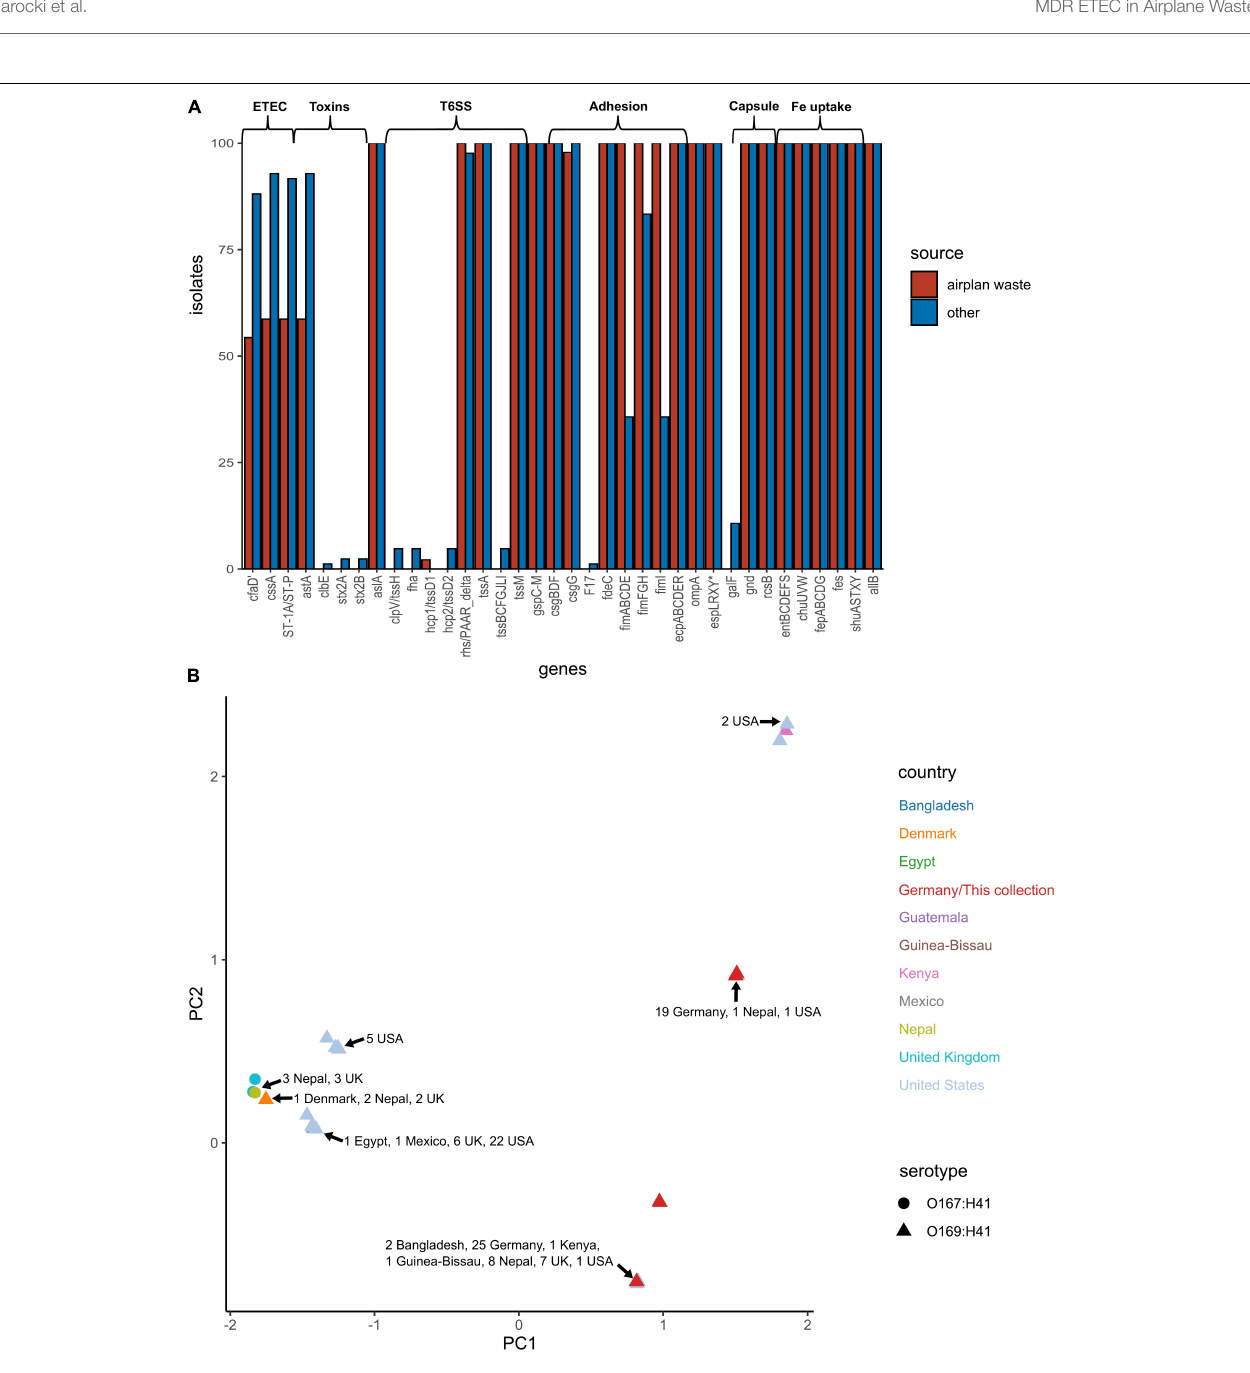
FIGURE 5 | Virulence-associated gene (VAG) profile of E. coli ST182 strains. (A) Bar graph comparing distribution of VAGs identified in both airplane waste ST182 isolates (red) and other ST182 strains (blue). (B) MDS analysis of VAGs detected in ST182 isolates. Where identical profiles cause shapes to overlap, arrows have been added detailing the country of isolation for each clustered